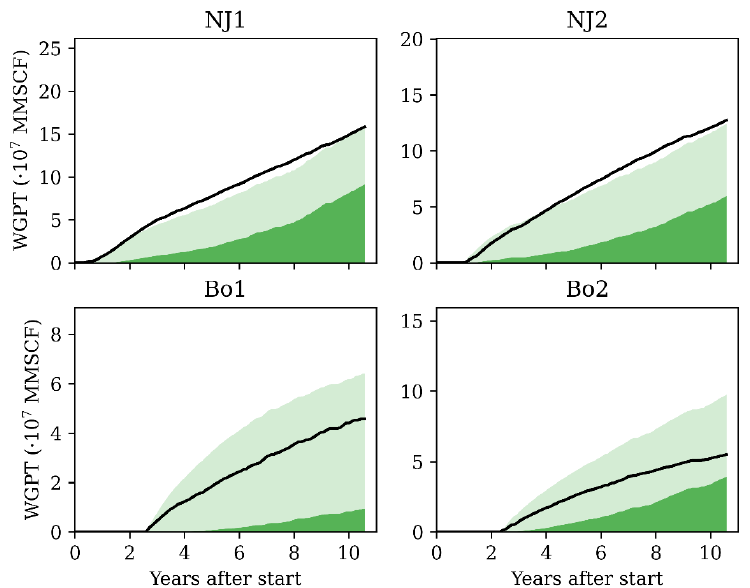
Figure 19. The produced gas volumes for the North Jens and Bo wells for the case of f g = 0.21. Dark and light green colors correspond to the production of the free and solution gas at reservoir conditions, respectively. Black lines denote the historical gas production data.